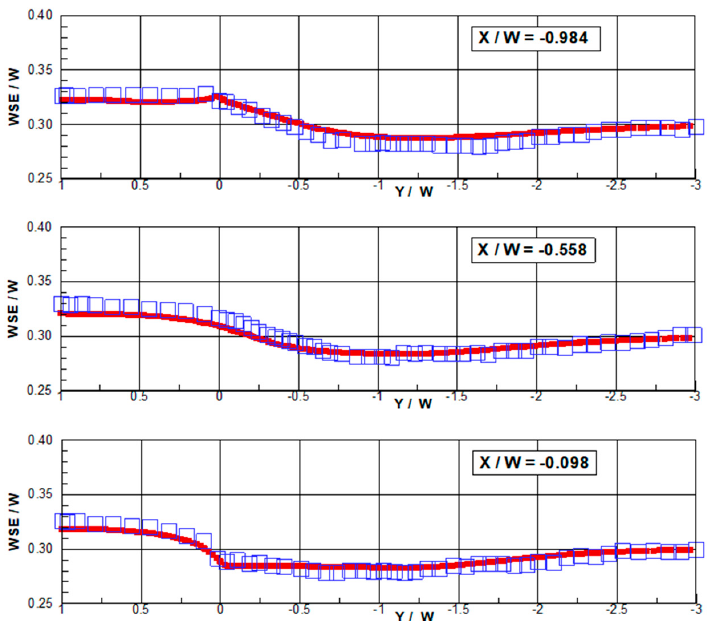
Figure 3. Comparison of the water surface elevation (WSE) variation along the side channel (three y lines); x = 0 is at the upstream corner of the juncture; the coordinates and water elevation are normalized by the channel width W).